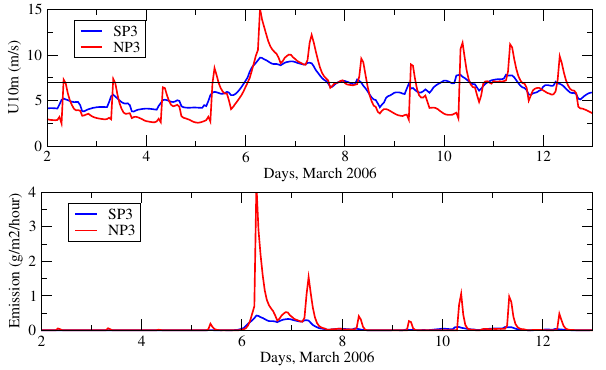
Figure 3. Comparison from 2 to 13 March 2006 of the 10m wind (upper panel, ms − 1 ) and emissions (lower panel, gm − 2 h − 1 ) for simulations SP3 (blue) and NP3 (red) in the grid cell, selected for emission analysis at 7.5 ◦ W, 18.5 ◦ N (shown in red in Fig. 1). The horizontal line in the upper panel corresponds to a wind of 7ms − 1 , above which emissions start to be